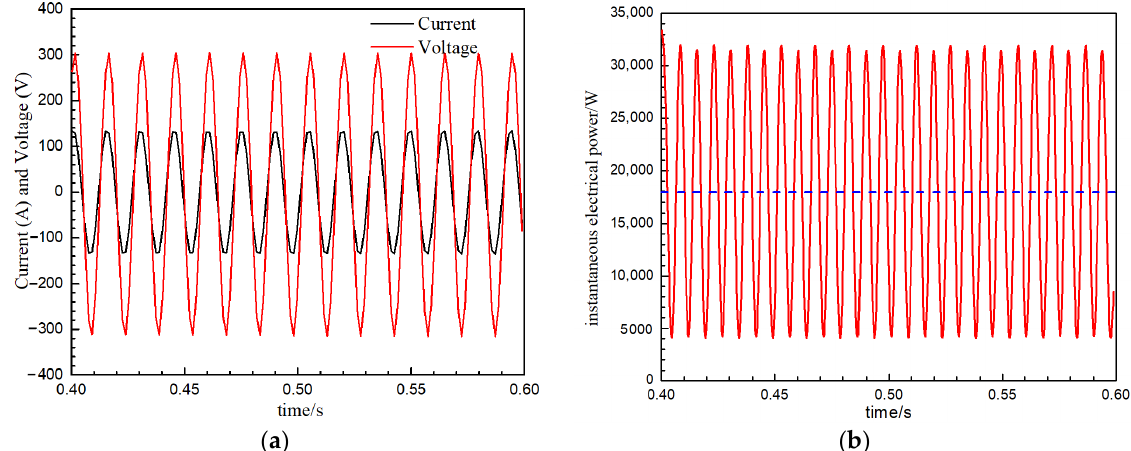
Figure 11. The electrical power, current, and voltage for the CTPC alternator: ( a ) Current and Voltage, ( b ) electric power.